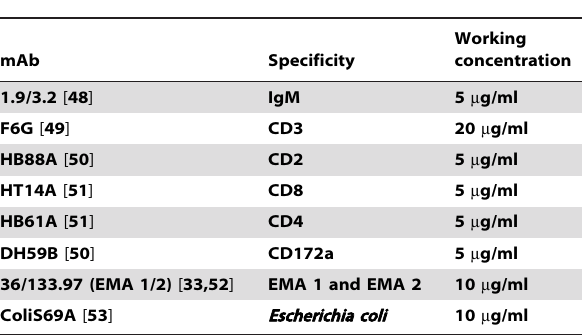
Table 1. Monoclonal antibodies